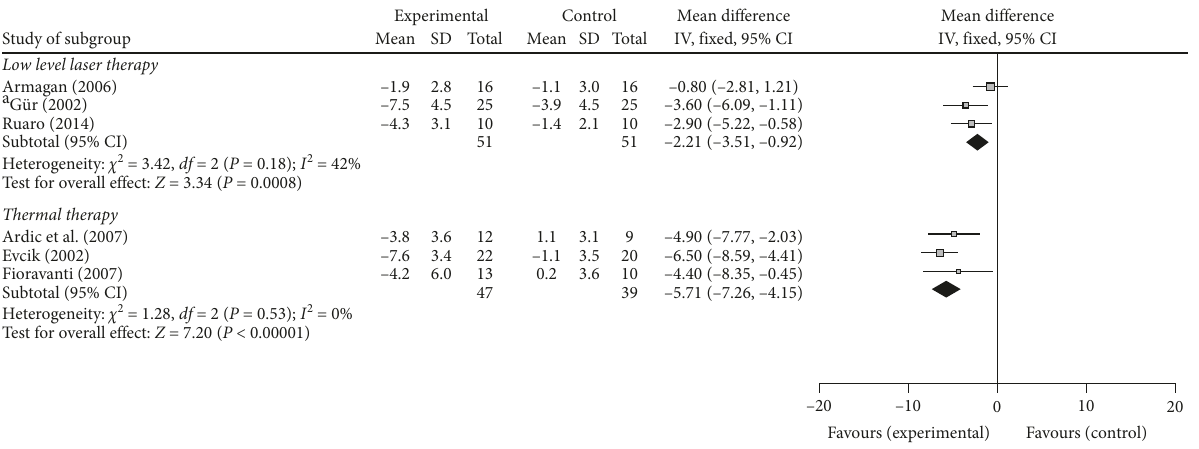
Figure 3: The mean difference and 95% confidence interval (CI) of tender points for physical-agent